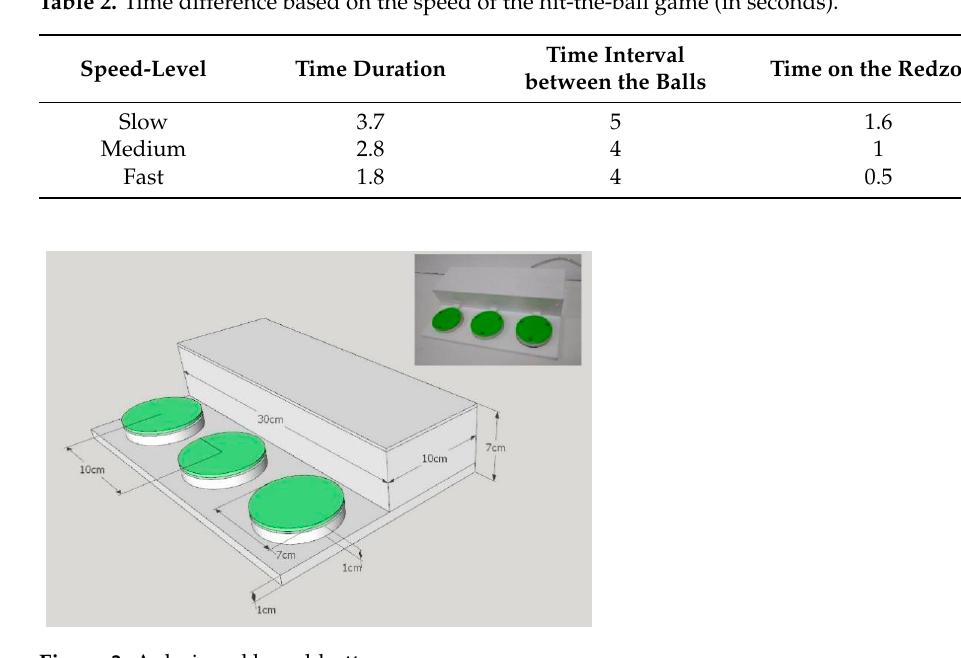
Figure 3. A designed board-button.